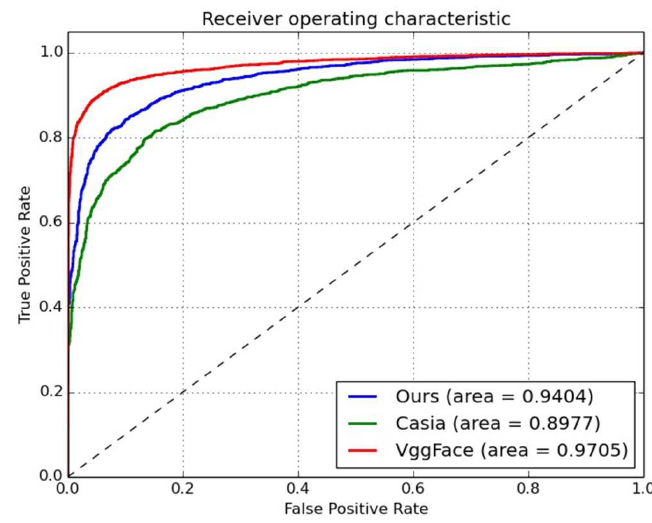
Figure 14. ROCs on LFW dataset with the unsupervised